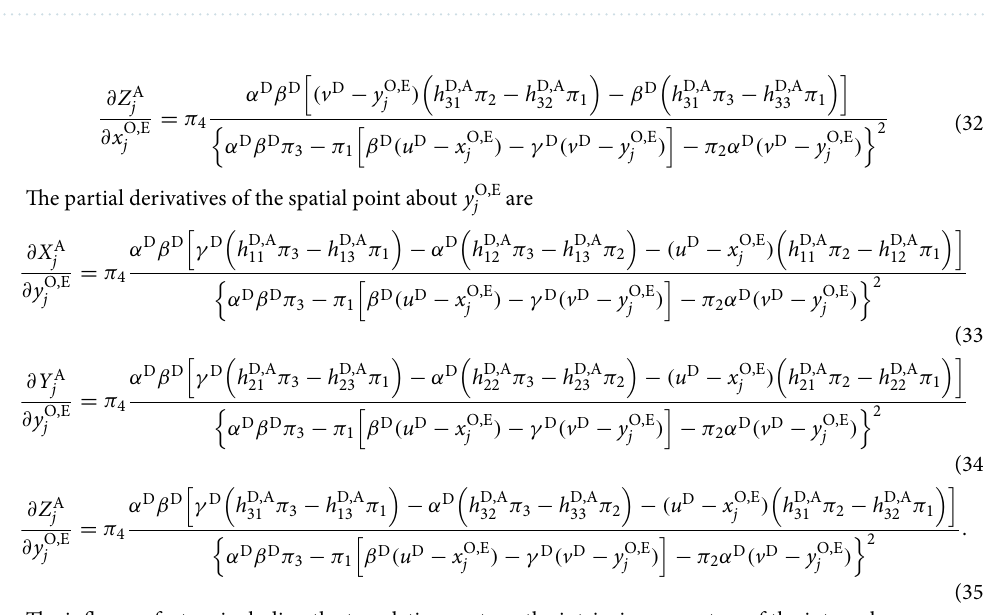
Table 1. Extrinsic parameters of cameras. R D,C and t D,C are the rotation matrix and translation vector from CSIC to CSOB. R C,A and t C,A are the rotation matrix and translation vector from CSOB to